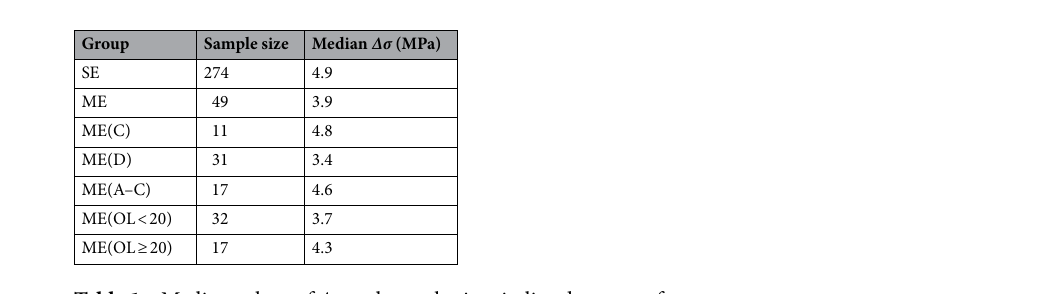
Table 1. Median values of ∆σ and sample sizes in listed groups of